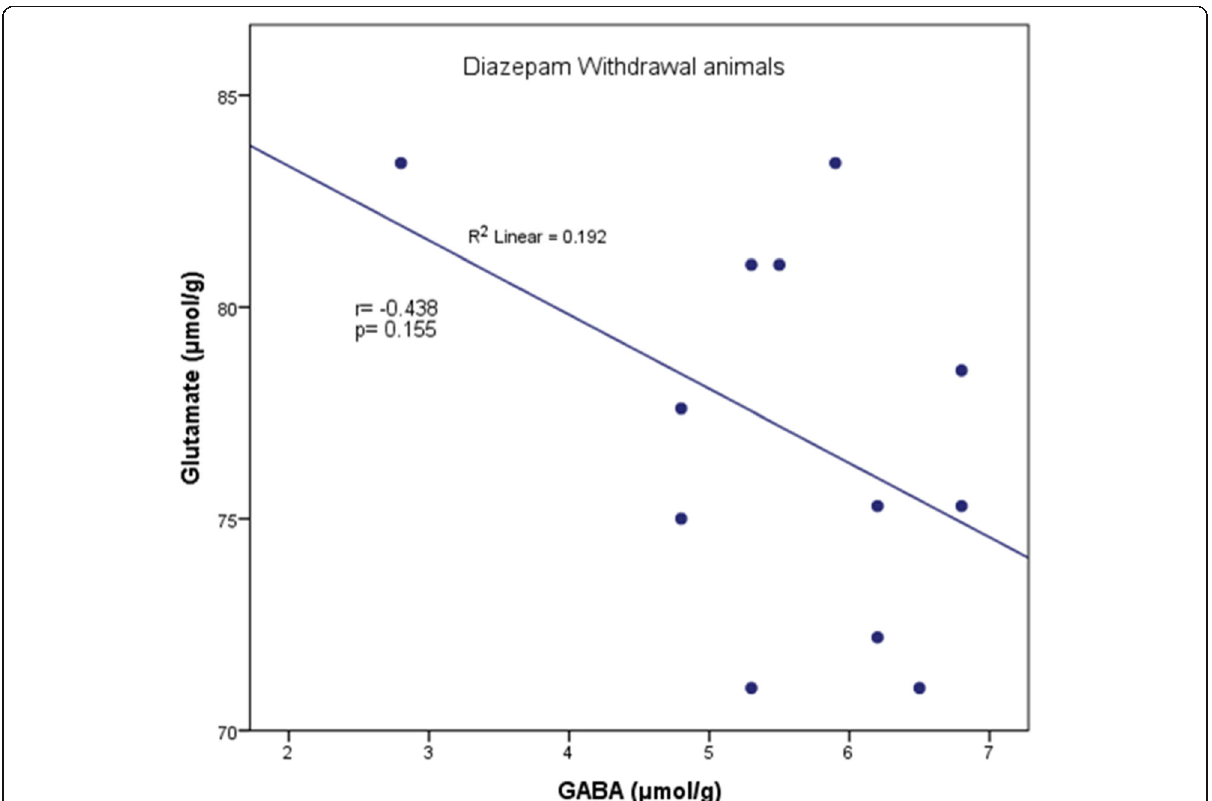
Fig. 7 Correlation between GABA and glutamate concentration in untreated diazepam withdrawal